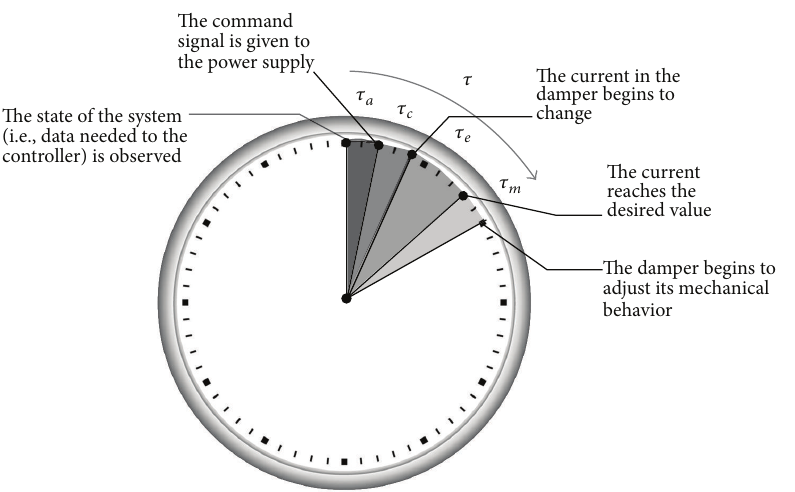
Figure 6: Schematic representation of time delays in a control chain involving MR dampers.